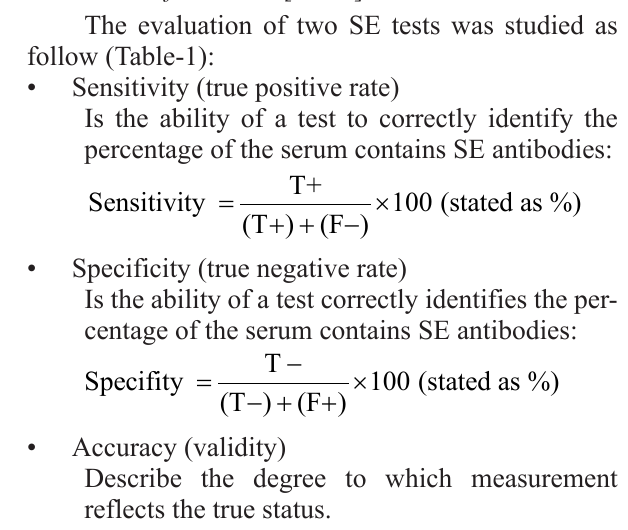
Table-1: Evaluation of diagnostic kit by using Salmonella Group D antibody ELISA kit (gold standard). Test (LFIT) or local prepared